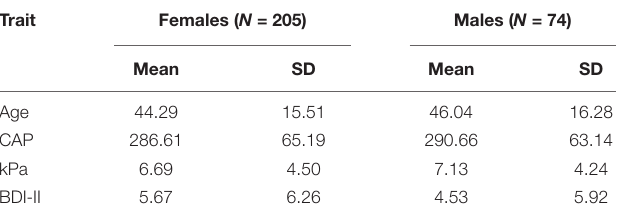
TABLE 1 | Demographic characteristics of the sample.